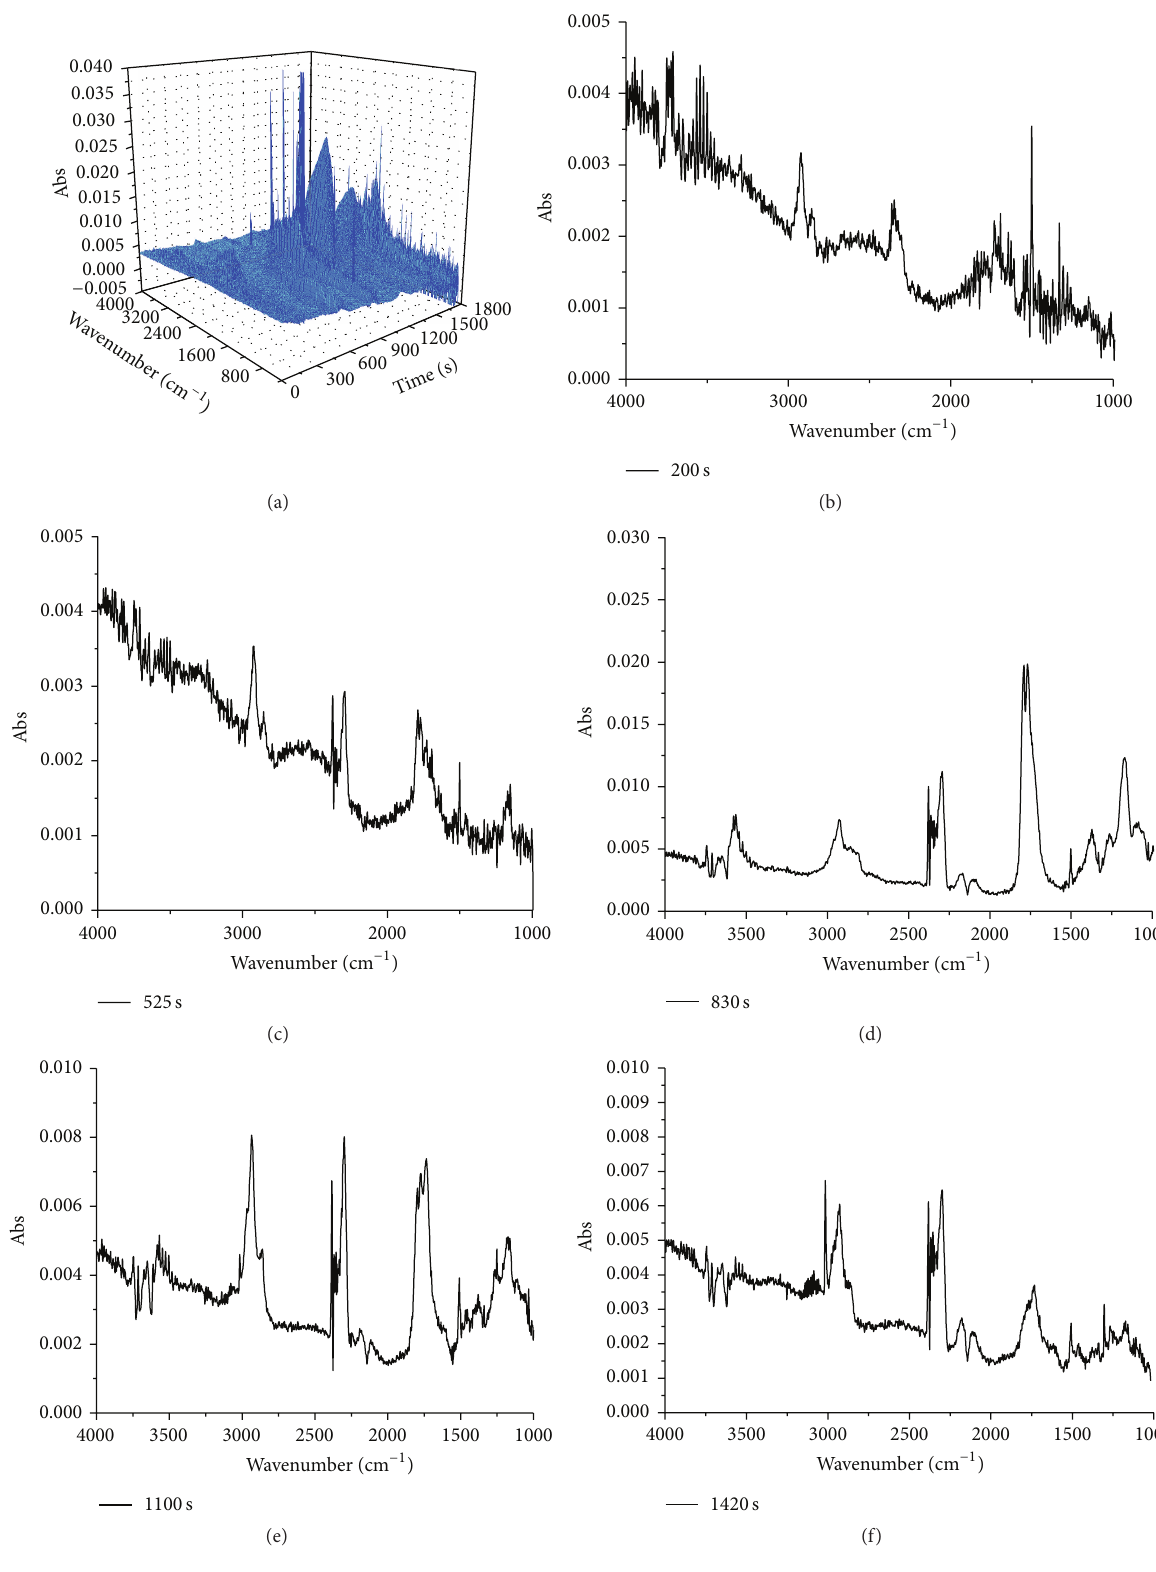
Figure 4: FTIR spectra of willow leaves at different times. (a) Three-dimensional IR spectrum of willow leaves and IR spectra obtained at (b) 200 s, (c) 525 s, (d) 830 s, (e) 1100s, and (f) 1420